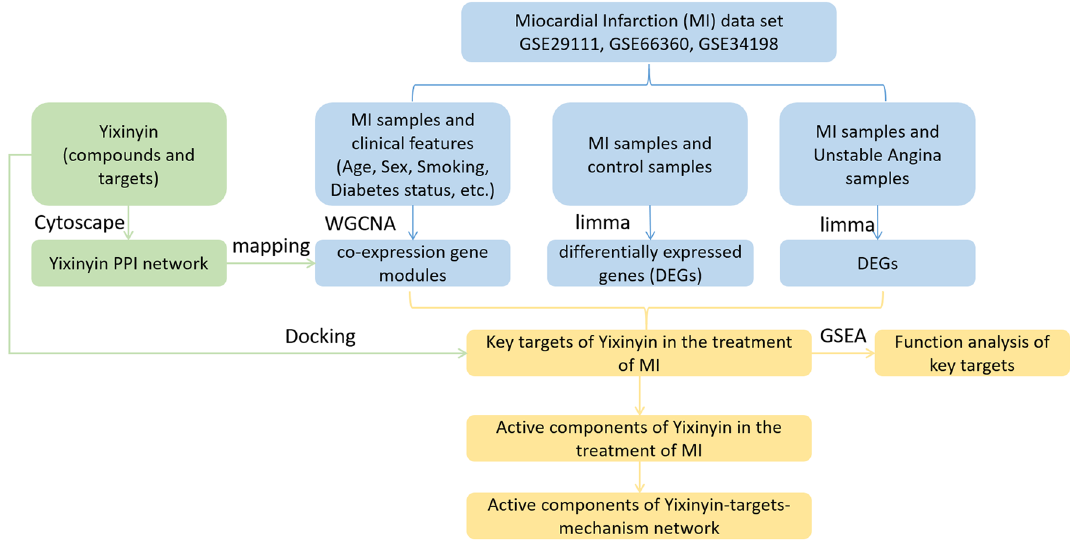
Figure 1. The flow chart of the whole research